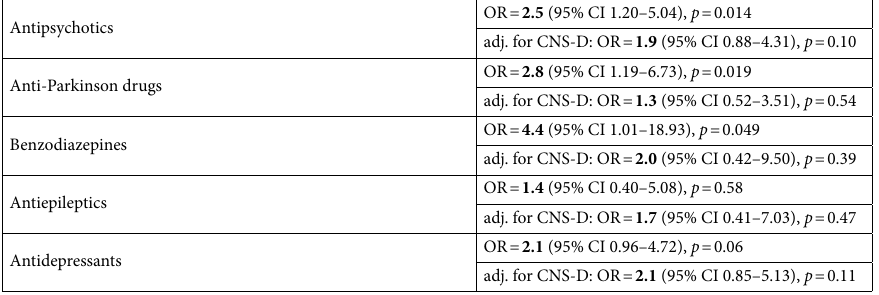
Table 3. Psychopharmacological drug groups associated with higher incidence of OD. Each group was also adjusted for CNS diseases (CNS-D).